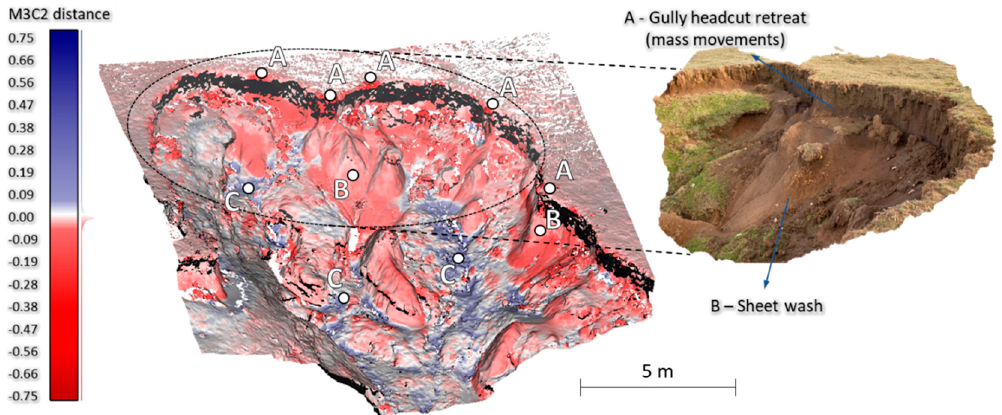
Figure 13. Point cloud representing the soil erosion induced STCs (M3C2 distance) between Decem- ber 2019 and December 2020 ( A — mass wasting; B — sheet erosion ; C — material accumulation below gully headcut